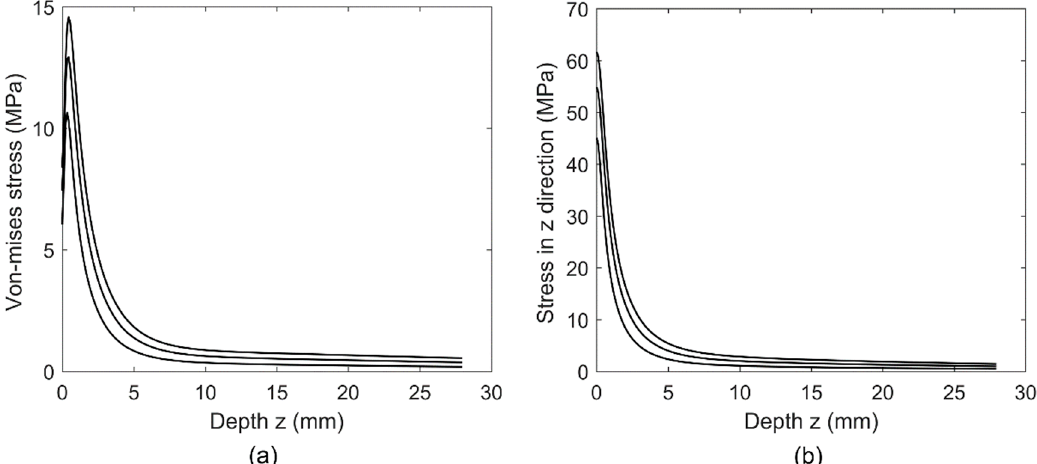
Figure 4. Variations of von-Mises stress, S VM , ( a ) and z -component stress, S z , ( b ), with the depth z for w = 1960, 3920, 5880 (N) from bottom to top.